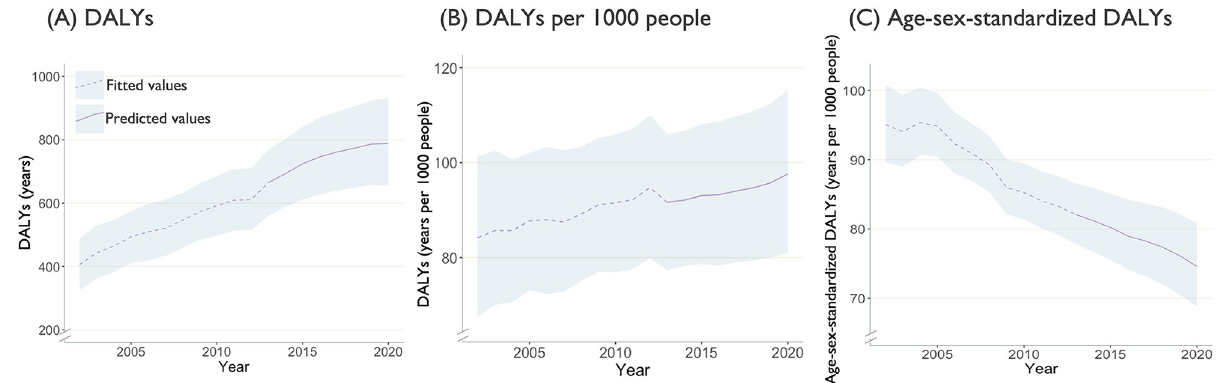
Fig 5. Fitted (2002–2012) and predicted (2013–2020) DALYs, with 95% credible intervals, associated with non-AIDS-defining cancers among people living with HIV in British Columbia, Canada. Note: DALYs: disability-adjusted life years. Direct age-sex-standardization was done using Canada’s 2011 census as reference population. Vertical scales differ for each graph for illustration